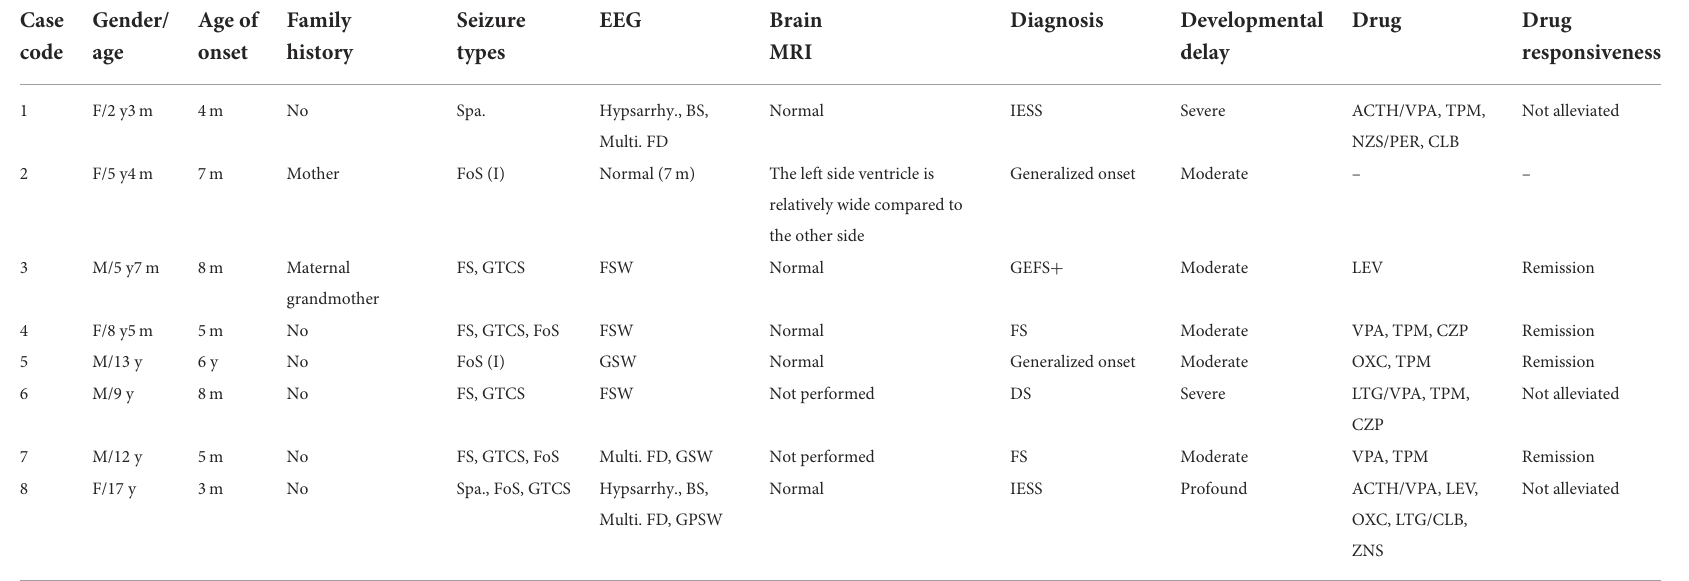
TABLE 2 Clinical features of patients with GABRA1 pathogenic